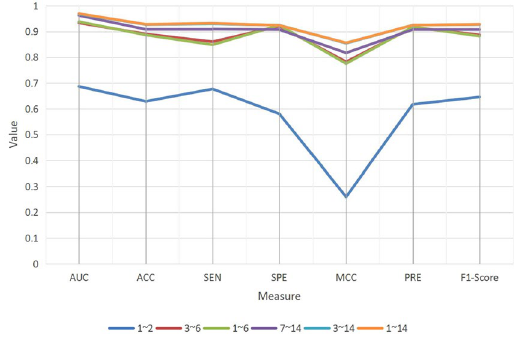
Figure 3. The performance comparison of different paths. The X-axis represents different performance measures and the Y-axis indicates the values of these measures. The colored lines denote the performances of different paths.